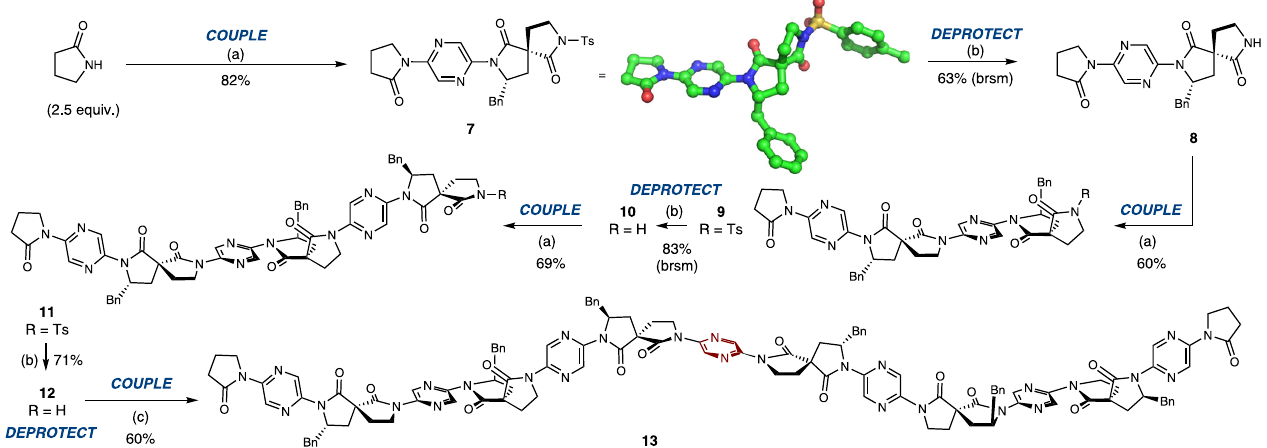
Fig. 3 Iterative synthesis of spirocyclic foldamers. a 6 (1-1.2 equiv.), Pd 2 (dba) 3 (10 mol%), Xantphos (30 mol%), Cs 2 CO 3 (2.5 equiv.), PhMe, 80 °C; b TfOH (5-9 equiv.), DCE, 80 °C, 8 h; c 2,5-dibromopyrazine (0.5 equiv.), Pd 2 (dba) 3 (10 mol%), Xantphos (30 mol%), Cs 2 CO 3 (2.5 equiv.), PhMe, 80 °C, 2 h, 60% yield. Supplementary Data 2 and CCDC 2170496 contain the single crystal data for 7 . TfOH tri fl uoromethanesulfonic acid, DCE 1,2- dichloroethane; dba